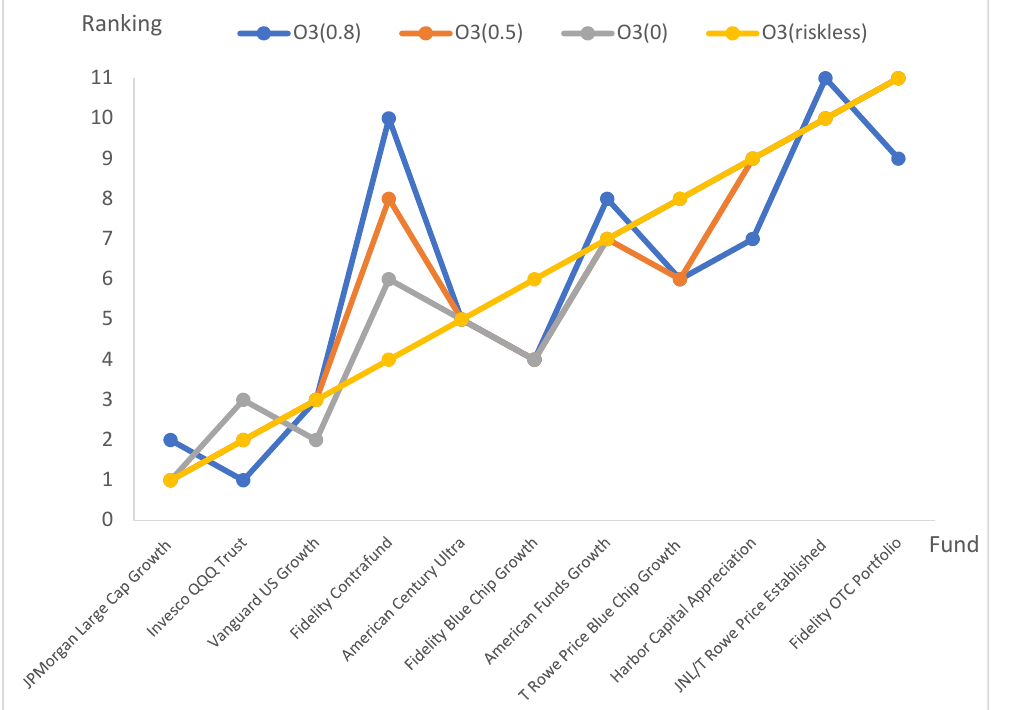
Figure 1. The 1st-, 2nd-,3rd-order Omega rankings at different thresholds. Note: X-axis shows the eleven funds’ ranking when the L = riskless rate at different order of Omega. Y-axis shows the ranking when L = 0.8, 0.5, 0, and riskless respectively.